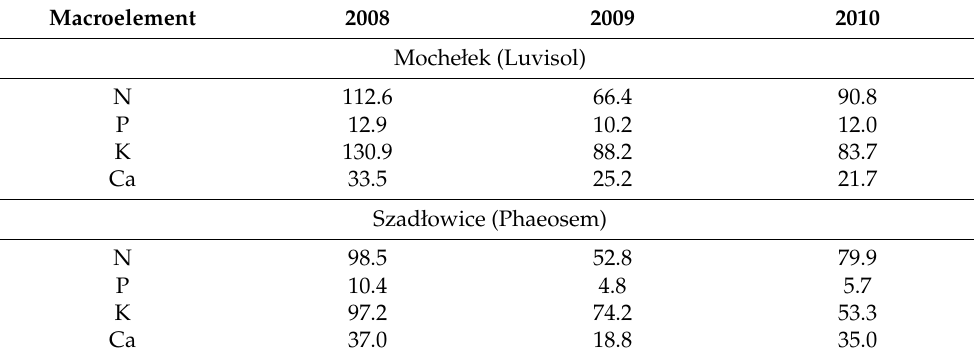
Table 2. The content of macroelements in catch crop biomass (kg · ha − 1